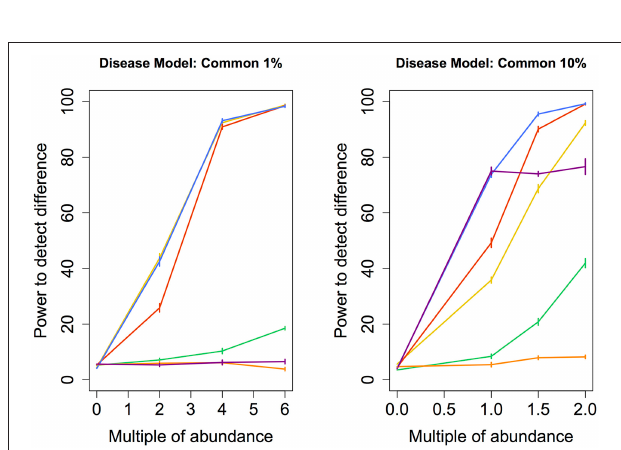
FIGURE 3 | Medium disease model: power comparison of the best performing statistical techniques from each category. Bars represent standard errors of the mean. [Purple: modified metastats; Blue: Partial least squares regression (1%-10 components, 10%-50 components); Red: principal components regression (50 components); Orange: diversity; Green: distance-based regression (1%-Manhattan distance, 10%-Minkowski distance with p = 0.5 ); Yellow: regularized regression (1%-Lasso, 10%-Ridge regression)].